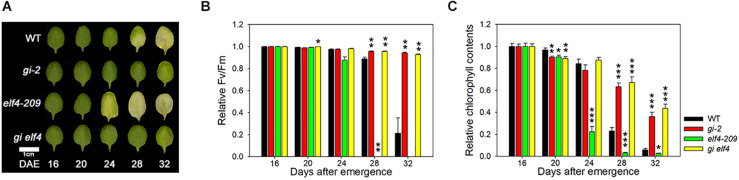
The gi-2 mutant allele is epistatic to elf4-209 in the leaf senescence pathway. (A) Photographs showing yellowing of leaves of wild-type (Col), gi-2, elf4-209, and gi elf4 plants at the indicated time points. DAE, days after emergence. The third and fourth rosette leaves were used for this experiment. Scale bar: 1 cm. (B,C) Fv/Fm ratio (B) and chlorophyll content (C) in leaves of the indicated genotypes at the indicated time points. Data are presented as mean ± SEM. Six biological replicates were performed. Asterisks indicate significant differences (*p < 0.05, **p < 0.01, ***p < 0.005; Student’s t-test).